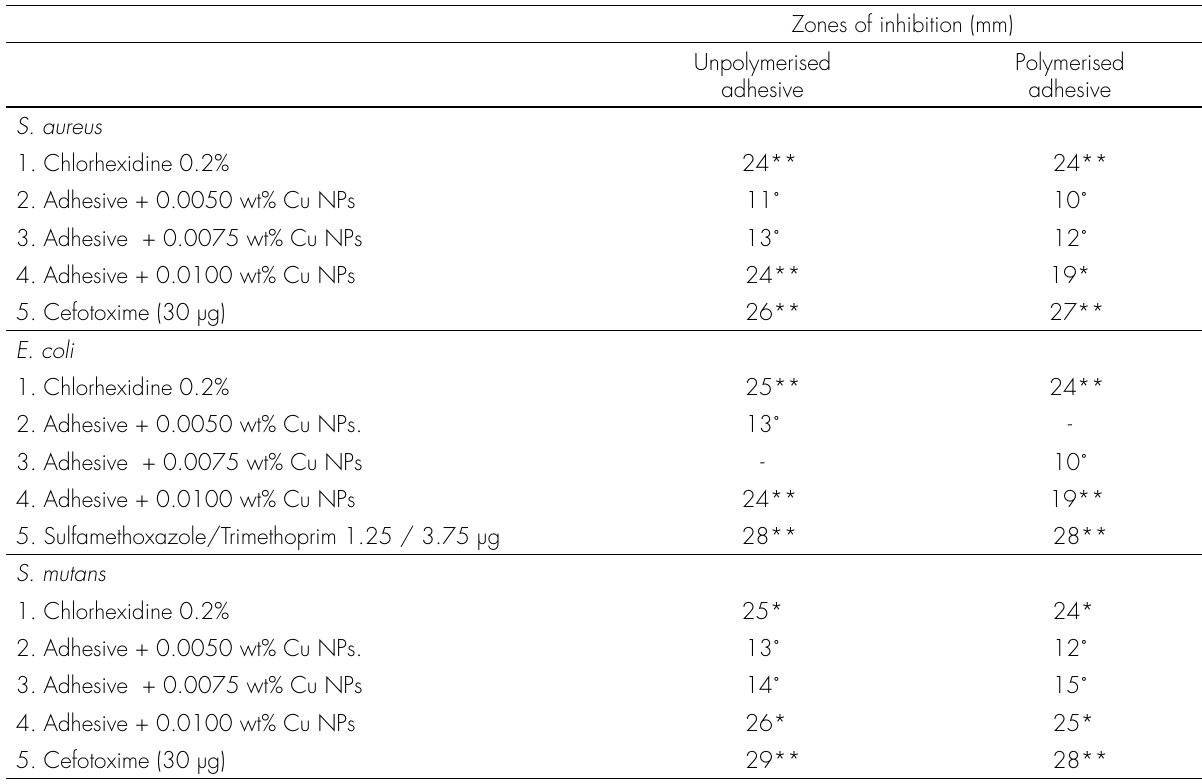
Table I. Zones of inhibition of different concentration of Cu NPs added to orthodontic adhesive.